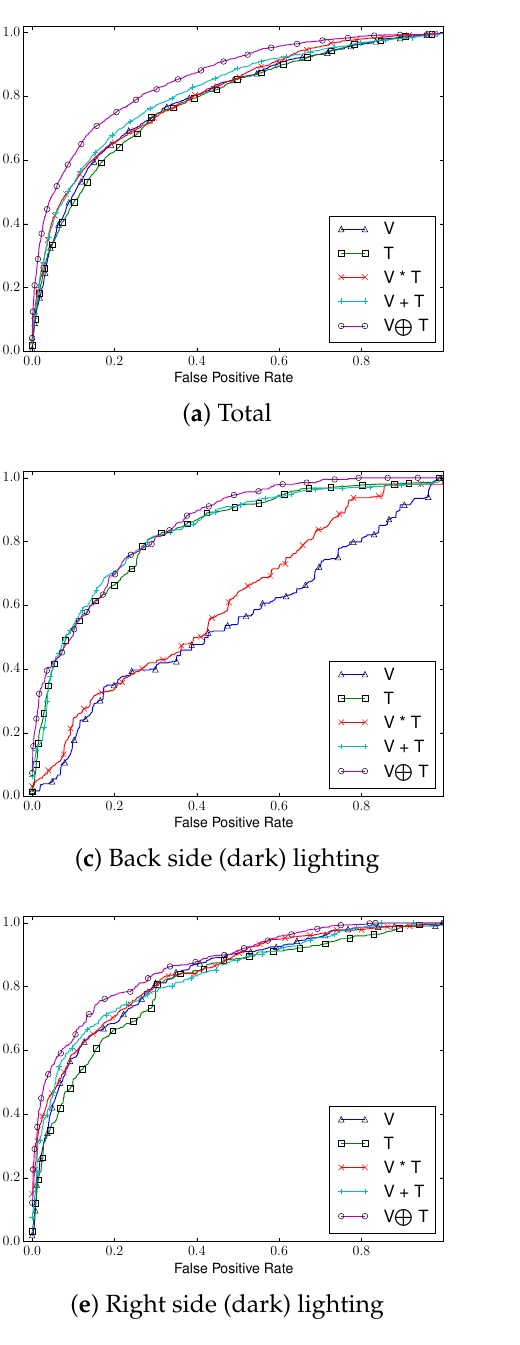
Figure 13. ROC curves of five compared methods in each lighting condition using SVM